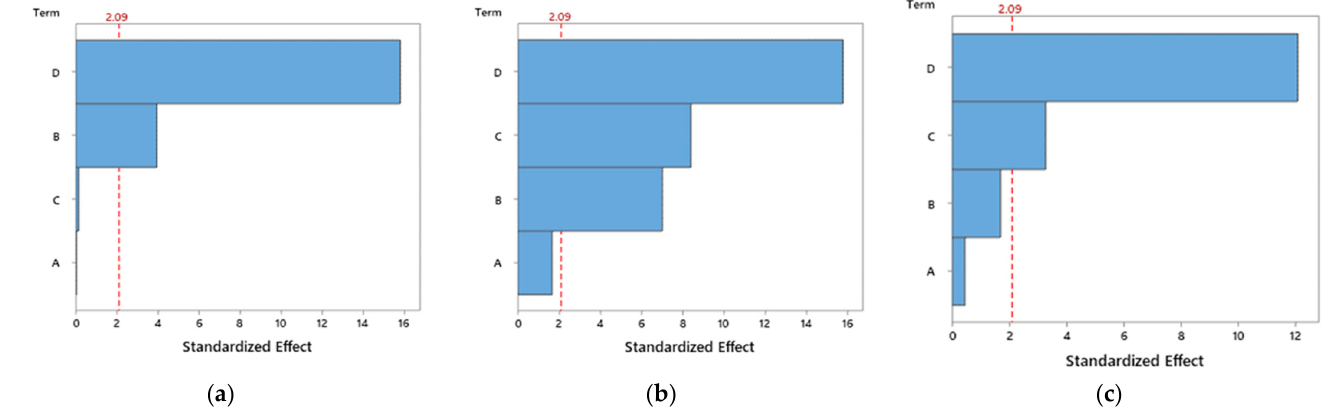
Figure 8. Pareto diagram for PETG+KF and for: ( a ) bending stress; ( b ) bending modulus; ( c ) bending strain.